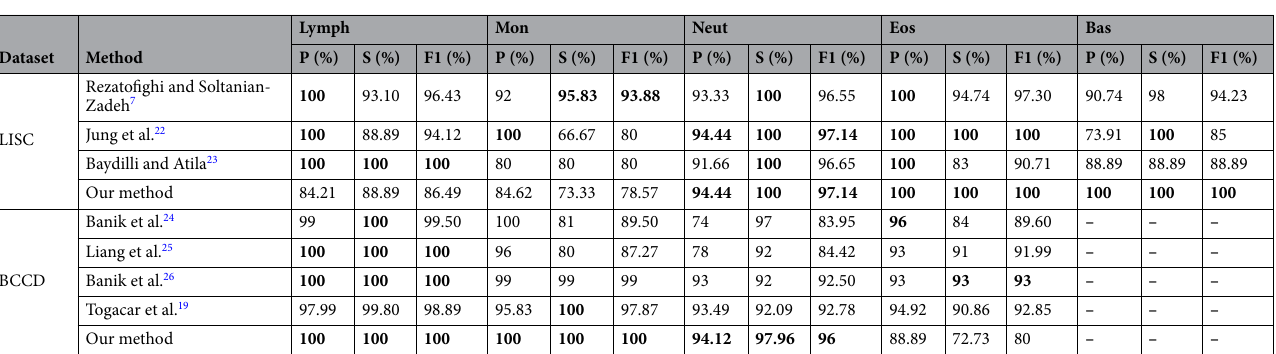
Table 6. The comparison of our method with other works; P (precision), S (sensitivity), F1 (F1-score). Bold values Illustrate the best-obtained